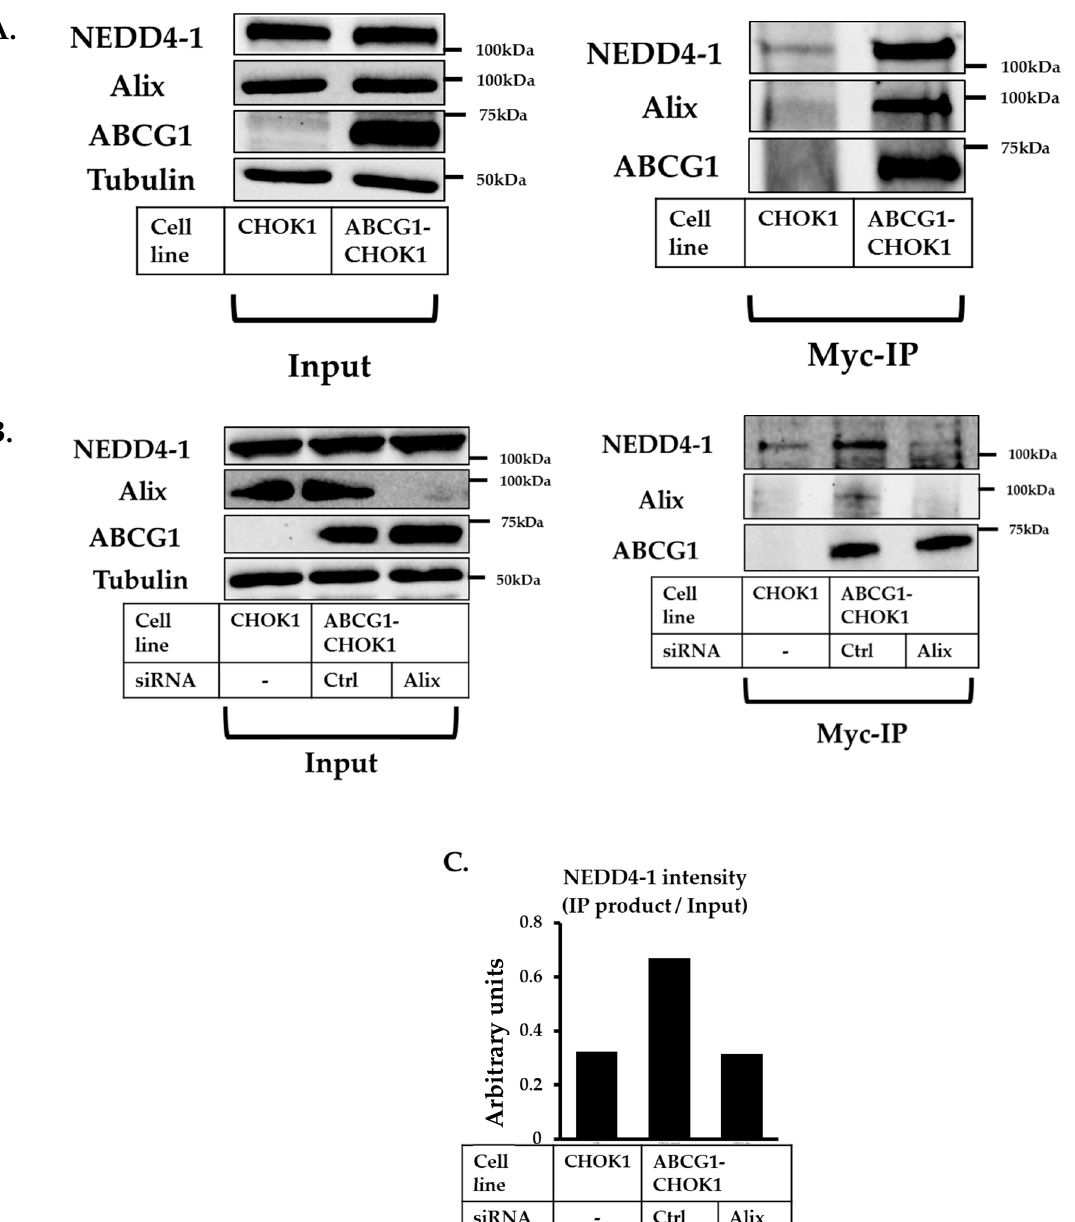
Figure 4. Apoptosis-linked gene 2-interacting protein X (Alix), Neural precursor cell-expressed developmentally downregulated gene 4 (NEDD4-1) and ABCG1 co-immunoprecipitation (co-IP). ( A ) IP of CHOK1 and ABCG1-CHOK1 cell lysates, immunoprecipitated with anti-myc antibody. Results are representative of two independent experiments. ( B ) IP of CHOK1 and ABCG1-CHOK1 cell lysates after knockdown of Alix (48 h), immunoprecipitated with anti-myc antibody. Results are representative of two independent experiments. ( C ) represents quantification of NEDD4-1 in IP product presented in Figure B, with / without Alix knockdown, relative to NEDD4-1 in whole cell lysate (Input).